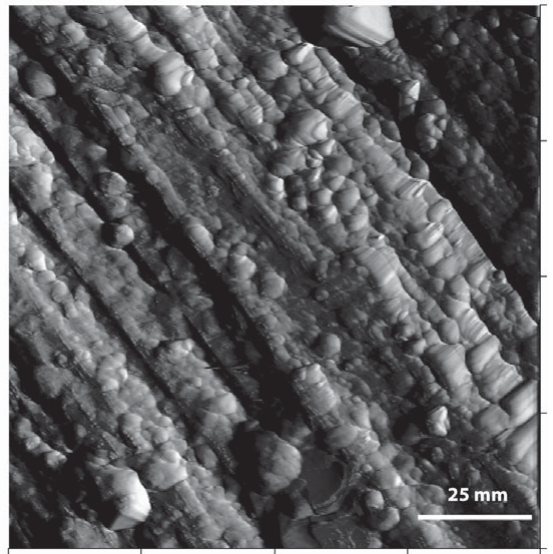
Figure 3 . AFM image of electro-spark deposited coating surface on stainless steel, showing nano-crystal structure produced by rapid solidification.